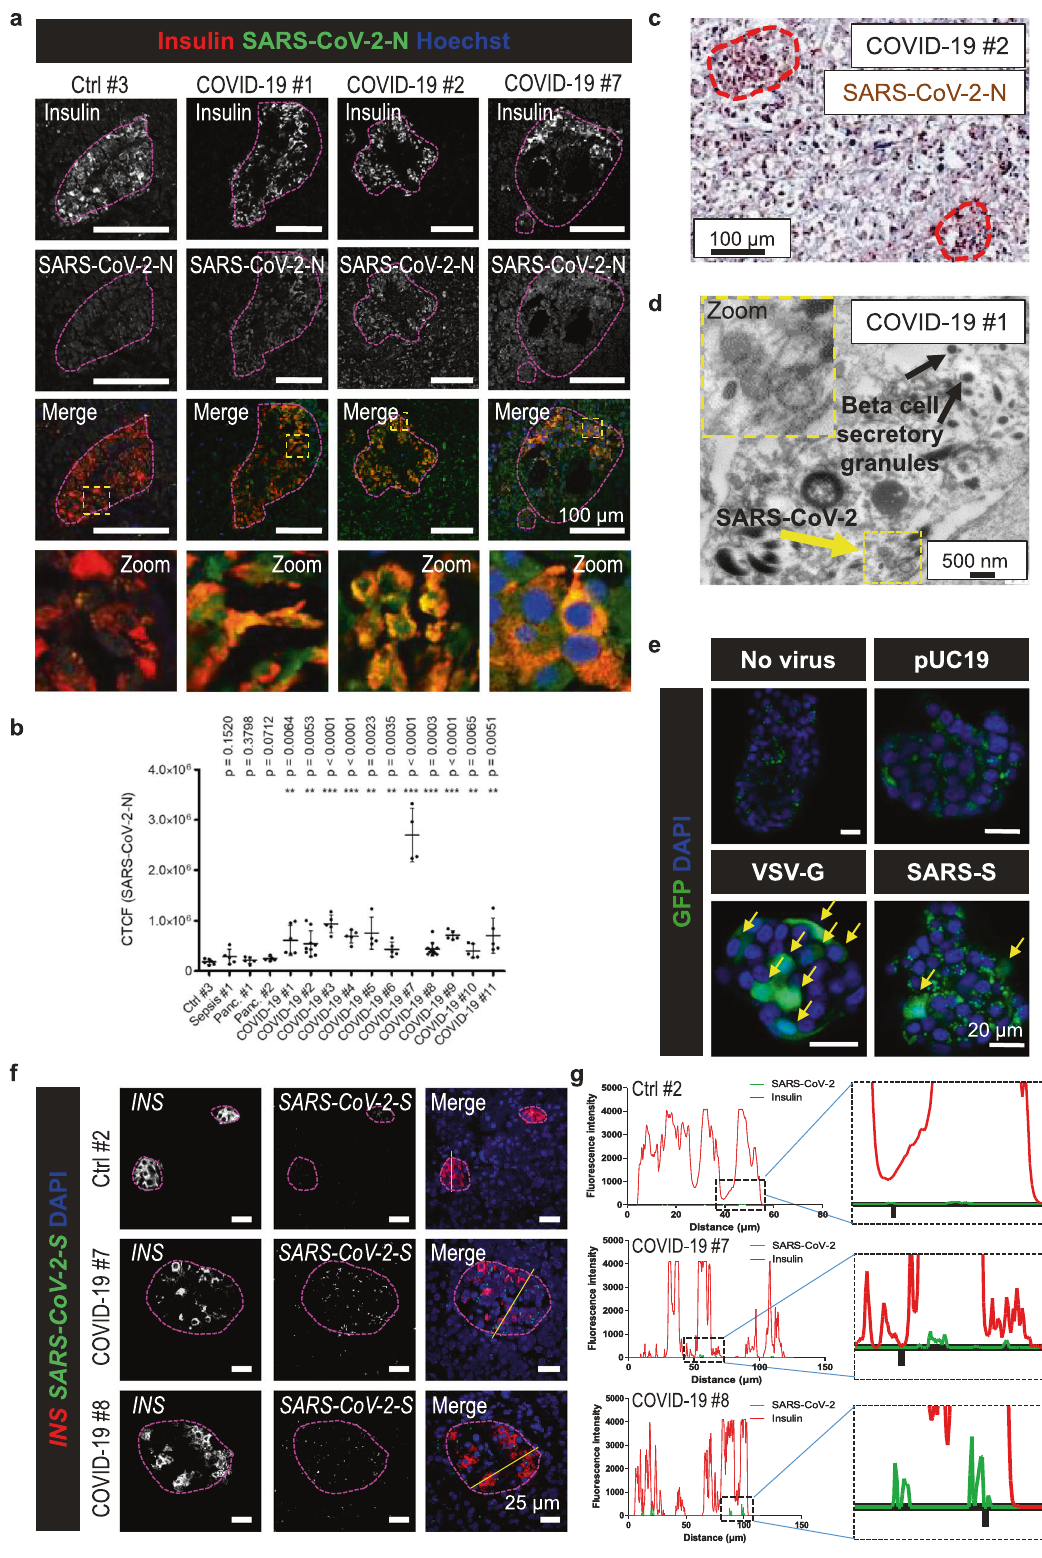
three COVID-19 patients (#5, #7, and #8), an increase in their diabetes, such as a family history of diabetes, increased age, and blood glucose to more than 200 mg/dL from admission to shortly obesity 23 . COVID-19 patient #8 was already diagnosed with type 2 diabetes and #5 had class 3 obesity, meaning that in these two before they died was observed (Table 1). These three patients cases, the observed hyperglycemia may at least partly be due by were treated with steroids, which are known to induce the glucocorticoid treatment. However, COVID-19 patient #7 and hyperglycemia in patients already exhibiting a risk of developing NATURE COMMUNICATIONS| (2021) 12:3534